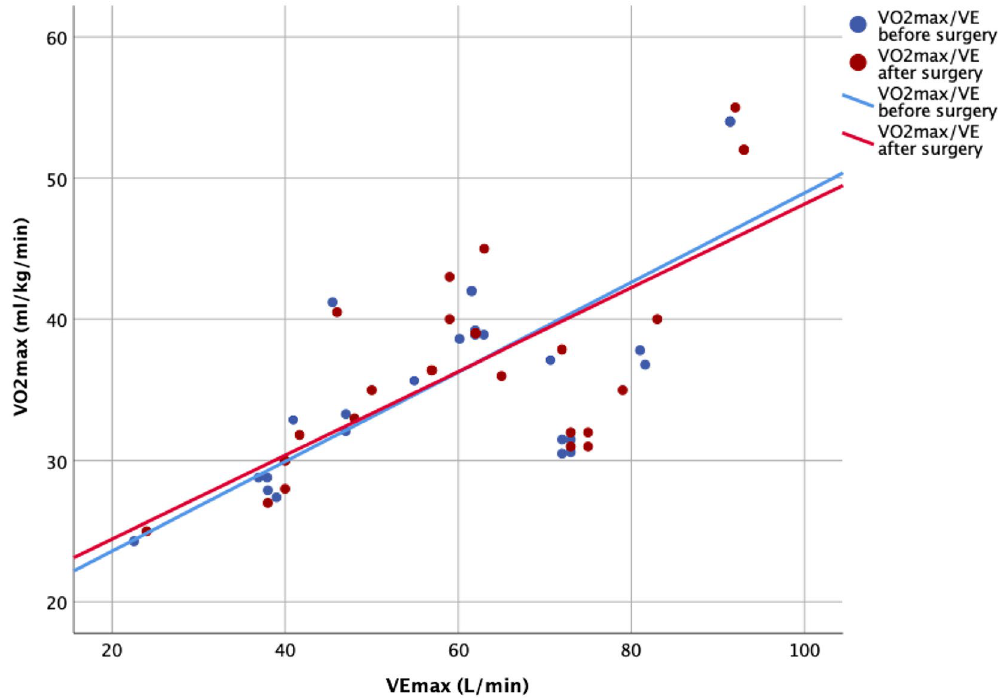
Figure 3. Correlation between VO 2 max y VEmax in the CPET before surgery (r = 0.725; P < 0.001) and 2-year after surgery (r = 0.699; P < 0.001).